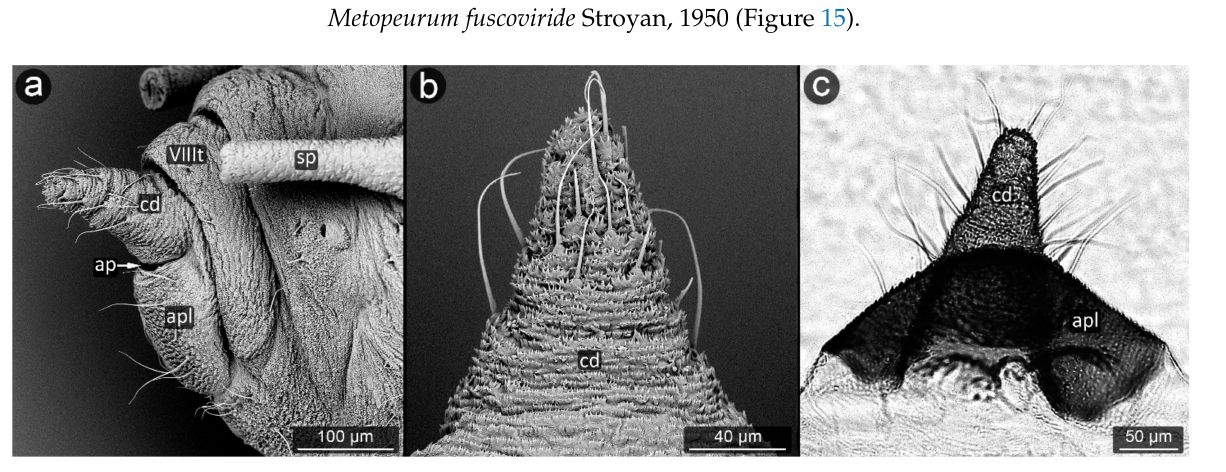
Figure 15. Perianal structure of Metopeurum fuscoviride ; ( a )—lateral view (SEM), ( b )—close-up of cauda (SEM), ( c )—rear view in light microscopy. Abdominal tergite VIII: cuticular microsculpture dense, with transverse rows of spinules; setae very short, blunt, not reaching cauda. Cauda: long, conical in shape. The cuticle surface is densely microsculptured, covered with rows of spinules, more prominent on the ventral surface. Setae on cauda are long, bent towards its apex.